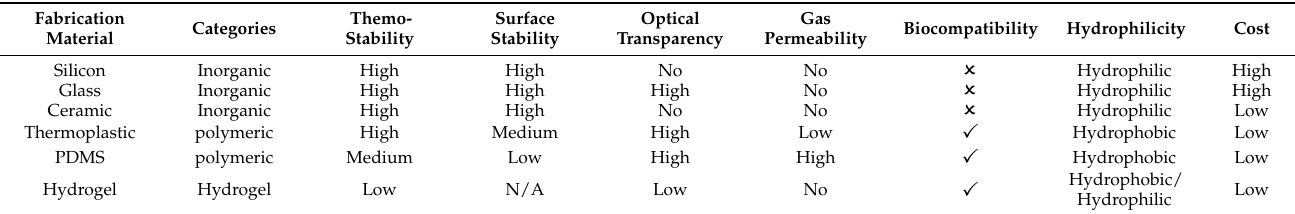
Table 1. Properties of different materials for microfluidic devices applied in neurobiology.